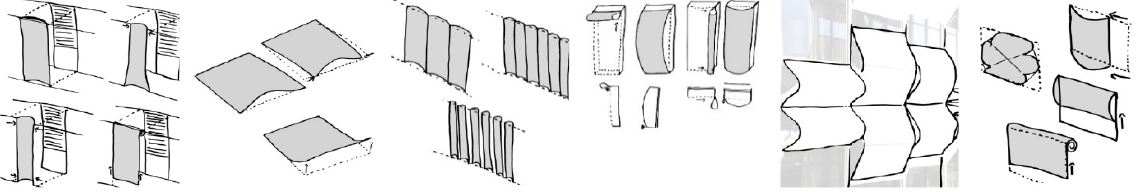
Fig. 4 Thin glass alternatives for building façade panels. (Ribeiro Silveira